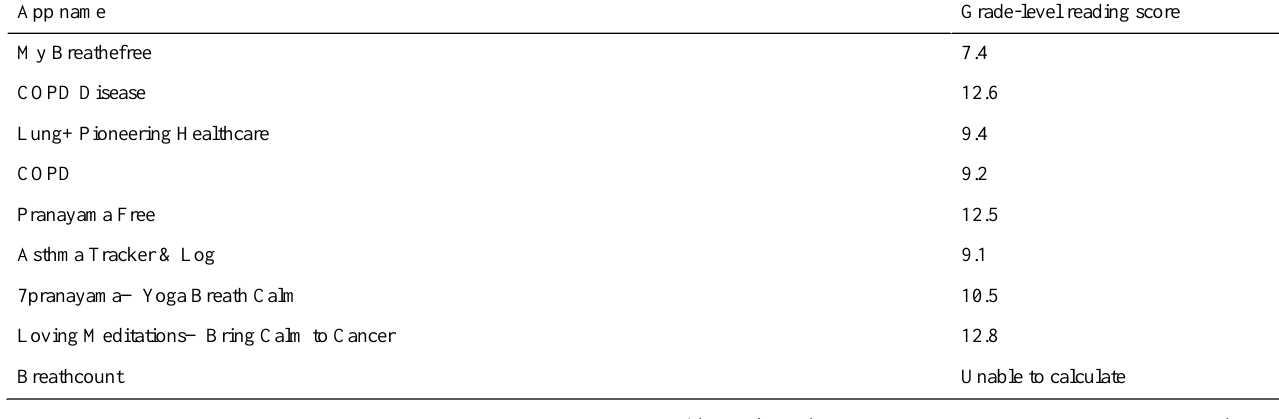
Table 3. Grade-level reading scores. COPD: chronic obstructive pulmonary